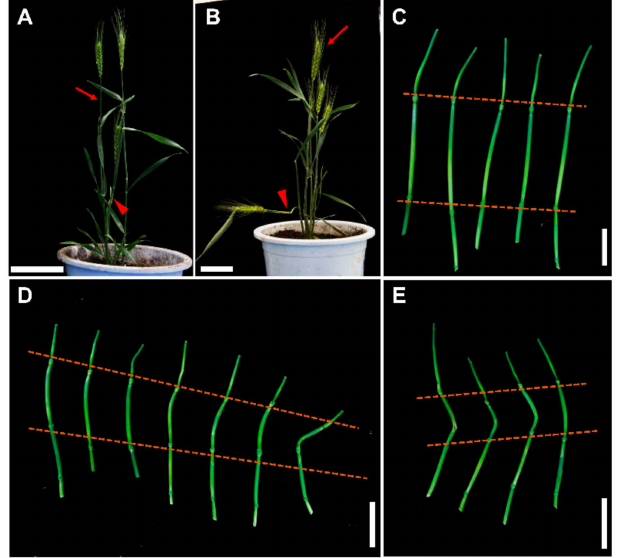
Figure 5. E ff ect of TaCLE3p and TaCLE34p on wheat stem. ( A , B ) Plants at 25 d after TaCLE3p ( A ) and TaCLE34p ( B ) treatment. The red arrows represent the stem of tillers treated with no peptide treatment, and the red triangle symbols represent the main stems treated with the corresponding peptide. ( C – E ) The stem of plants 7 d after the treatment of no peptide ( C ), TaCLE3p ( D ) and TaCLE34 ( E ). The red dasheds represent the internodes treated with synthesized peptides. Scale bars: 8 cm in ( A , B ), 3 cm in ( C ), 5 cm in ( D , B